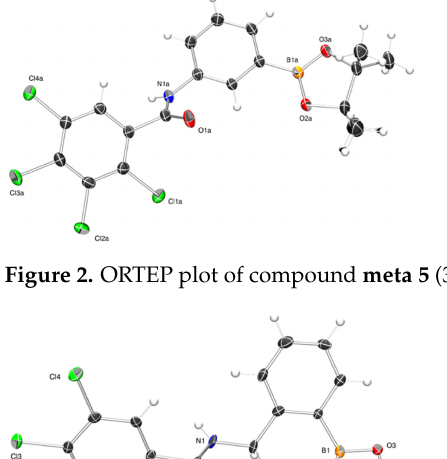
Figure 3. ORTEP plot of compound ortho 8 (30% ellipsoids). The boronic ester groups in both structures are close to coplanar with the adjacent phenyl ring (out of plane twist <10°) and the C-B bonds ( ortho 8 1.561(6) Å; meta 5 1.558(6) and 1.557(6) Å) are reinforced due to π -bonding with the sp 2 -hybridised B-atom. In